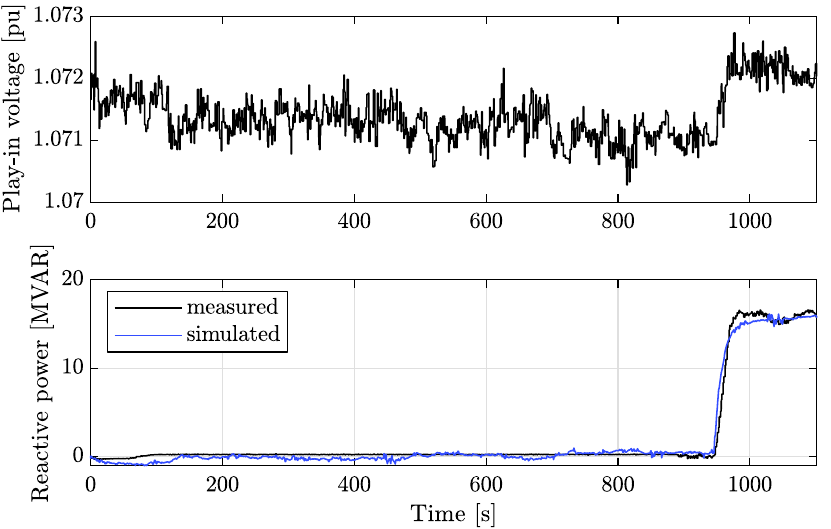
Figure 10. Volt/VAR Control Experiment 2 (low impedance connection to a nuclear plant): voltage reference step test. Comparison of the simulations and experimental